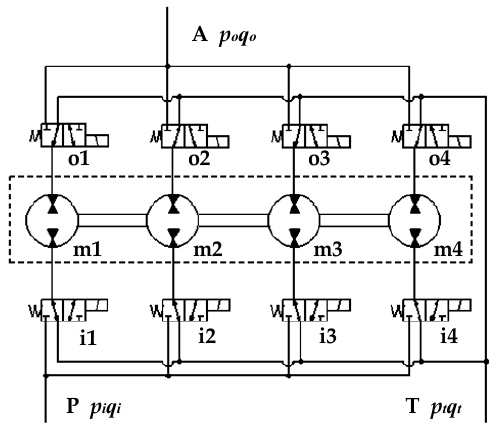
Figure 3. Working principle diagram of DHT.